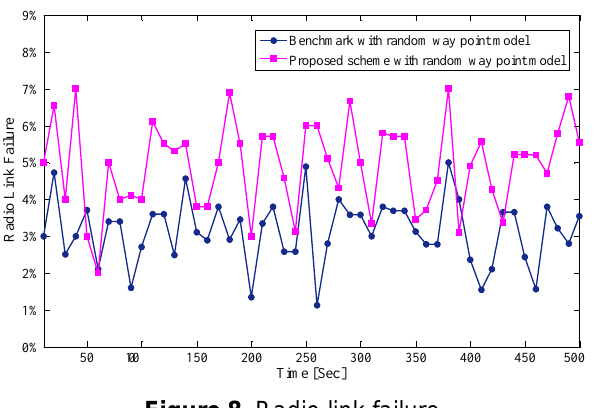
Figure 10. Carbon emission EAI Endorsed Transactions on Energy Web and Information